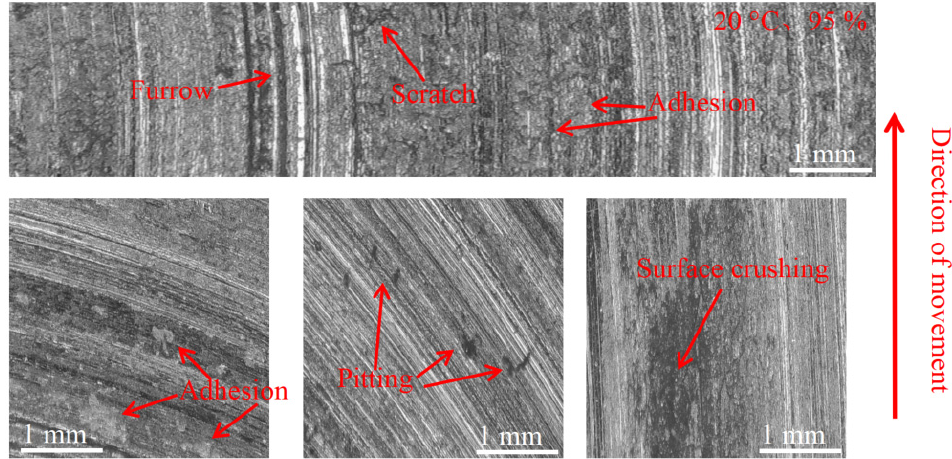
Figure 15. Surface morphology damage map of the disk at 20 °C and 95% ambient humidity.